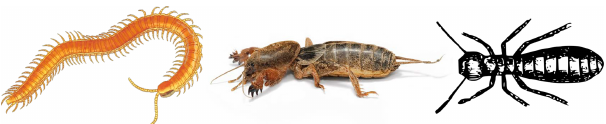
Figure 3. Animals as bio-inspiration for the robot-miner concept (centipede, mole cricket and